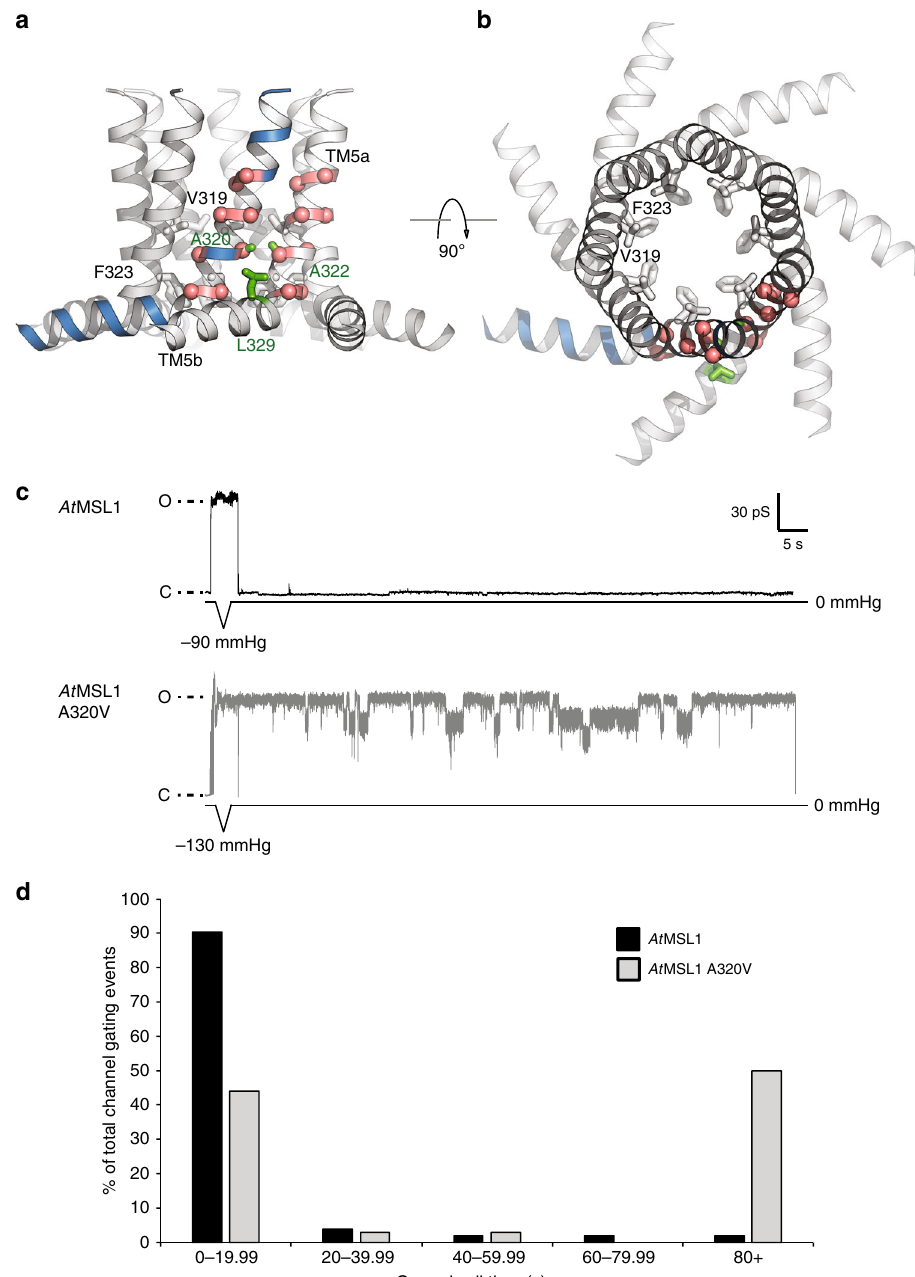
Fig. 3 Helix-helix interface and the A320V mutant. a , b Orthogonal views of TM5. Glycine and alanine residues are indicated as red spheres. A320 and its contacts in a neighboring helix (A322 and L329) are highlighted in green. V319 and F323 constitute the hydrophobic gate. c Representative traces for single At MSL1 and A320V channel activities in response to a brief 1 s pressure ramp followed by 90 s without pressure. Closed state (baseline) current is indicated by C while open states are indicated by O. The maximum negative pressure used is indicated. Membrane potential was clamped at − 70 mV. Multiple subconducting states were observed with the A320V mutant, while the peak unitary current of A320V was indistinguishable from that of the wild type (Table 3). d Percentages of At MSL1 (black) and At MSL1 A320V (gray) gating events with open dwell times of 0 – 19.99 s, 20 – 39.99 s, 40 – 59.99 s, 60 – 79.99 s, or 80 + s. Data represent traces obtained from 10 patches per variant channel with only the fi rst gating event analyzed per trace (103 traces for At MSL1, 34 for At MSL1 A320V). Source data are provided as a Source Data fi